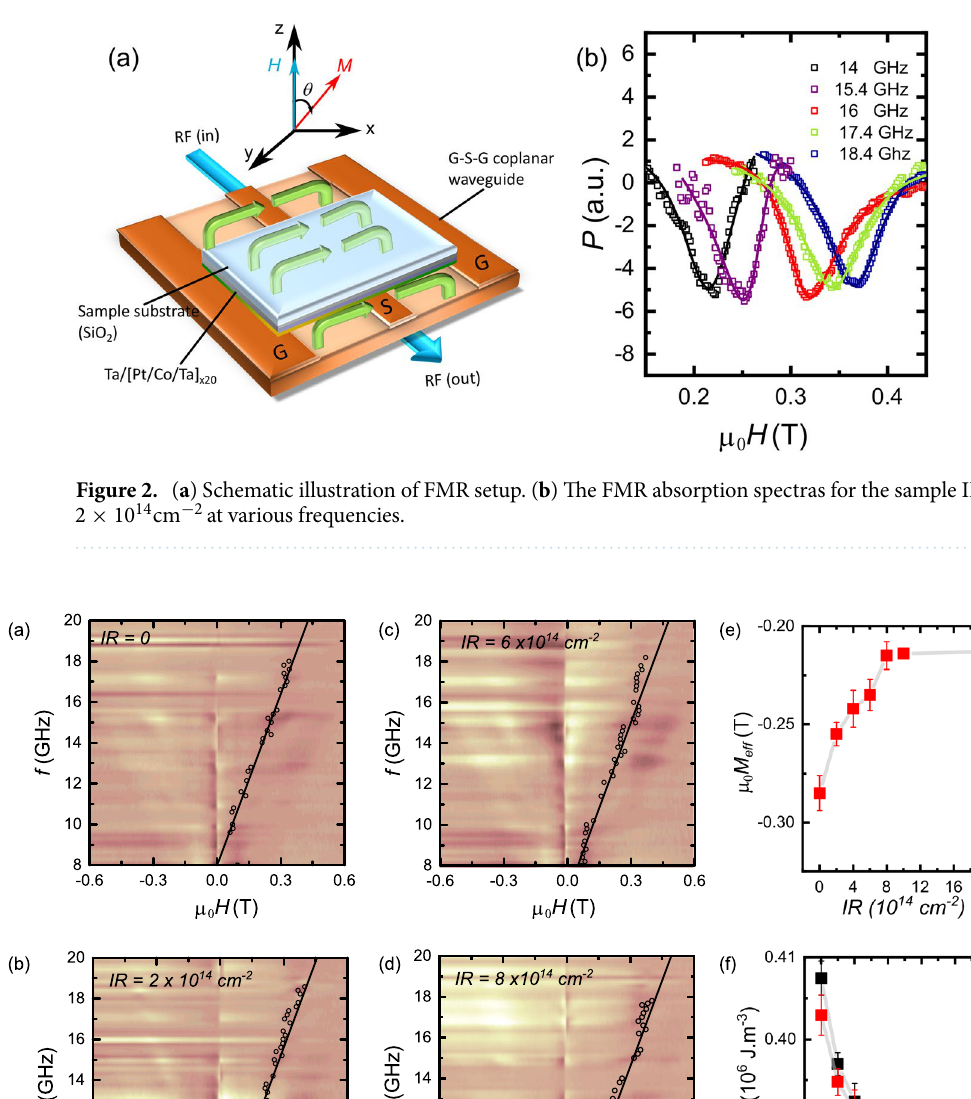
The extrinsic contributions to linewidth: magnetic inhomogeneity and two-magnon scattering can broaden the